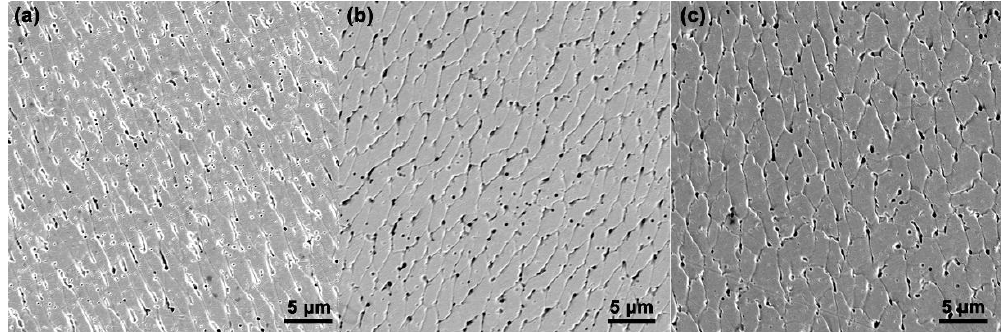
Figure 3. Microstructures of welds without preplaced powder ( a , b ) with FeCoNiCrMn powder and ( c ) FeCoNiCrAl powder.